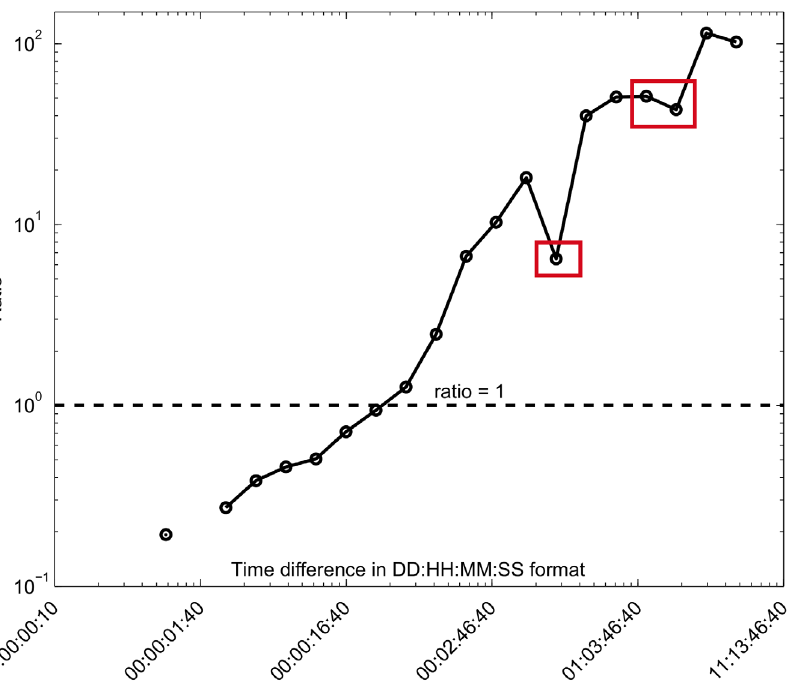
Figure 3. Ratio of the number of pairs of images above the bend to the number of pairs of images below the bend in NV’s correlation dimension plot as a function of binned time difference plotted on log-log axes. The ratio is approximately 1 for a time difference bin of 21 to 34 mins which lies in the range of median and mean context durations (see text for details). The drop in ratio for certain time differences, marked with the rectangles, are signatures of periodicities in the data where recurrent visits to the same context spaced by those time differences contribute more pairs to the lower scale of the correlation dimension plot thereby decreasing the ratio. Note that the second time difference bin = [73,118) seconds and there are no transitions with these time differences in the data - images were captured by NV’s lifelogging device at approximately equal intervals of , 60 seconds. The minimum time interval in the data is 59 seconds followed by 60, 61, 62 and 119